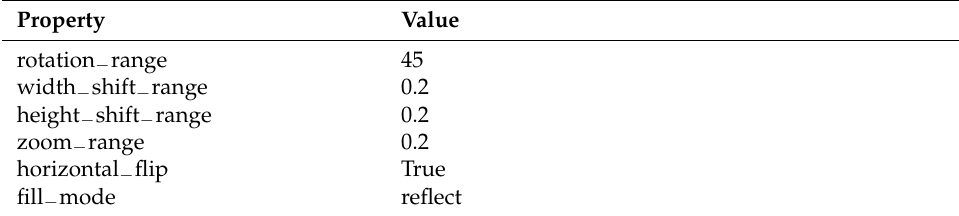
Table 2. Data Augmentation